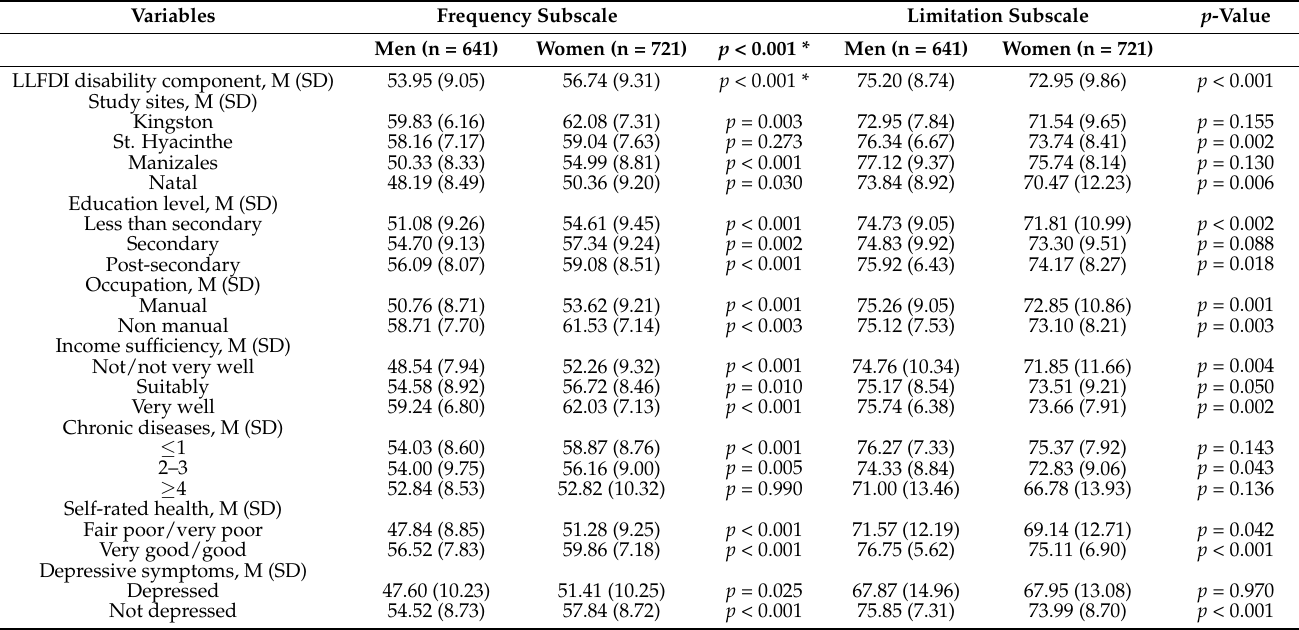
Table 2. Bivariate analysis between frequency and limitation subscales, socioeconomic and health characteristics by